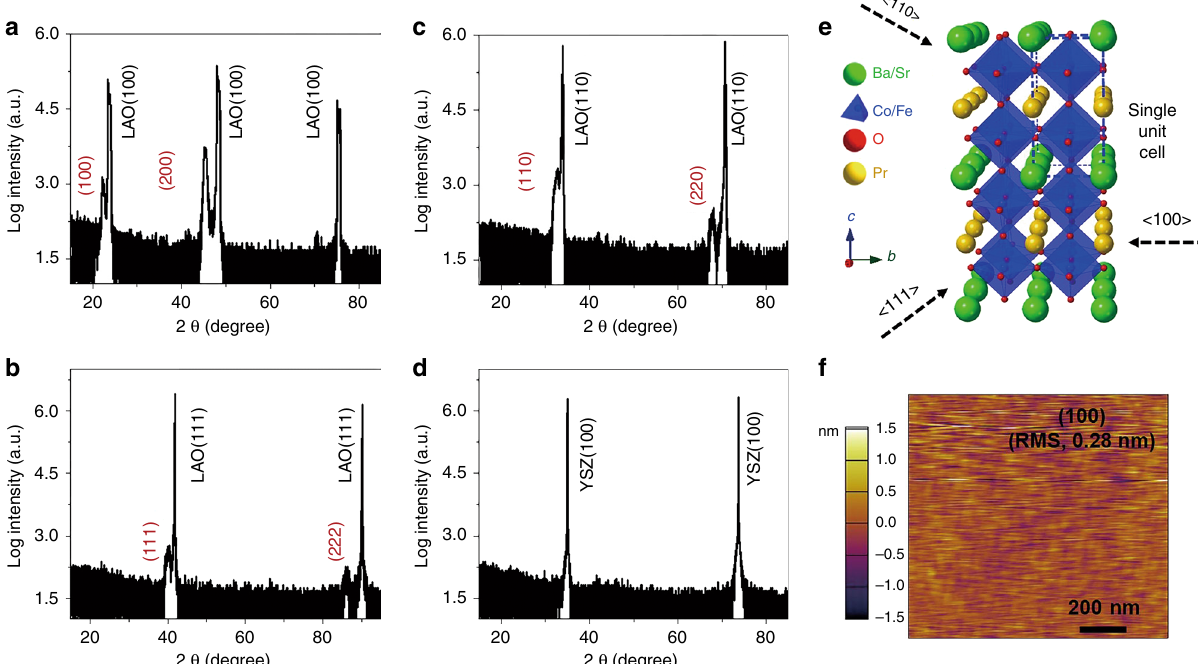
Fig. 1 Thin fi lm characterization. a – d HRXRD 2 θ – ω scans of a PBSCF (100) fi lm on LAO (100) ( a ) a PBSCF (111) fi lm on LAO (111) ( b ) a PBSCF (110) fi lm on LAO (110) ( c ) and a polycrystalline PBSCF thin fi lm on YSZ (100) ( d ). e A schematic of the crystal structure of PBSCF. The arrows indicate the directions of <100>, <110>, and <111>; f AFM images of a PBSCF (100) thin fi